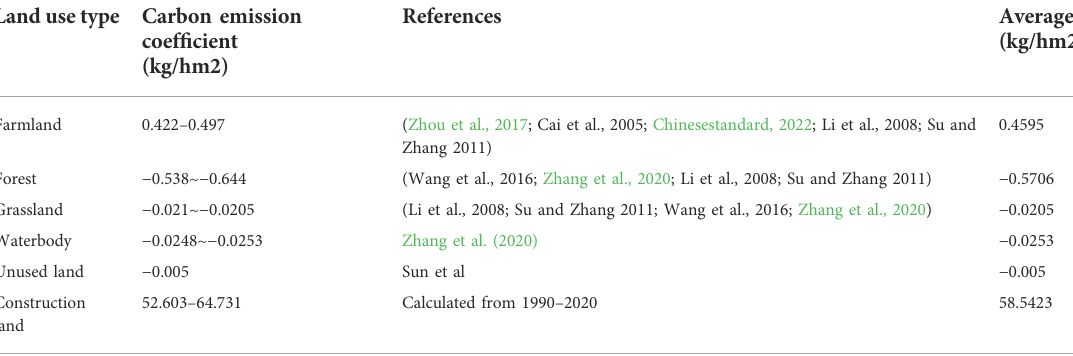
TABLE 1 Carbon emission coef fi cient of construction land in